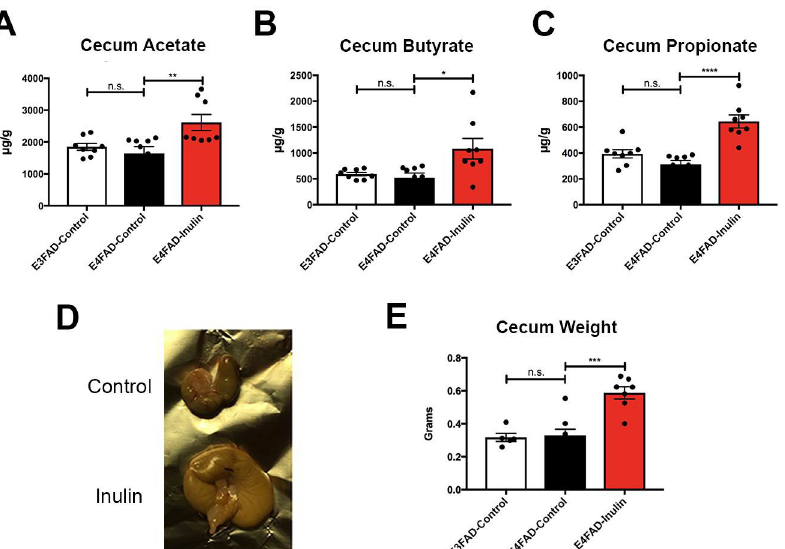
Fig 3. Analysis of inulin-induced changes in metabolism and weight in the cecum. E4 FAD-Inulin fed mice had significantly enhanced production of the short-chain fatty acids (A) acetate; (B) butyrate; and (C) propionate compared to the controls. E3 FAD-Control and E4 FAD-Control mice did not exhibit significant differences in these measures. (D) Representative images showing the significantly increased cecum size of the inulin-fed E4 FAD mice compared to the E4 FAD control mice. (E) Quantitation of data in (D) comparing the cecum weights among the three groups. Data are presented as the mean ± SEM. n.s. = not significant; � p < 0.05; �� p < 0.01; ��� p < 0.001; ���� p <